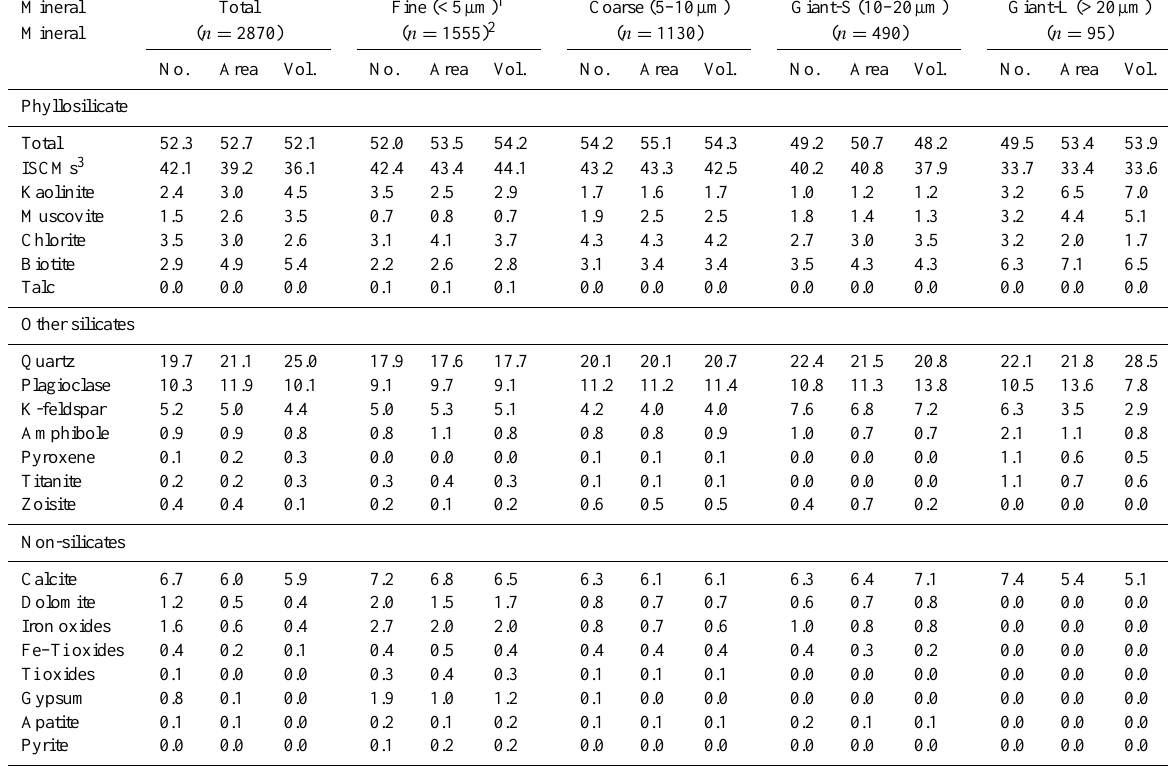
Table 2. Mineral compositions of Asian dust TSP collected on 31 March 2012 (unit in %). Mineral Total Fine (<5µm) 1 Coarse (5–10µm) Giant-S (10–20µm) Giant-L (>20µm) Mineral ( n = 2870) ( n = 1555) 2 ( n = 1130) ( n = 490) ( n = 95) No. Area Vol. No. Area Vol.